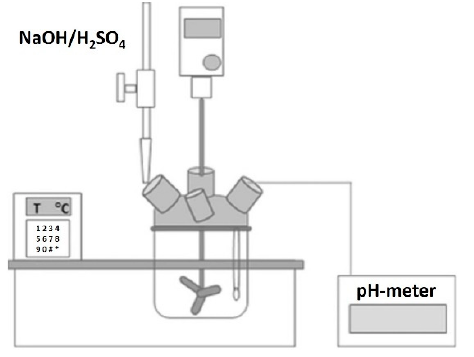
Figure 1. Experimental